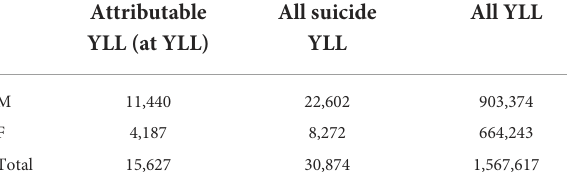
TABLE 4 Years of life lost due to premature death (YLL).